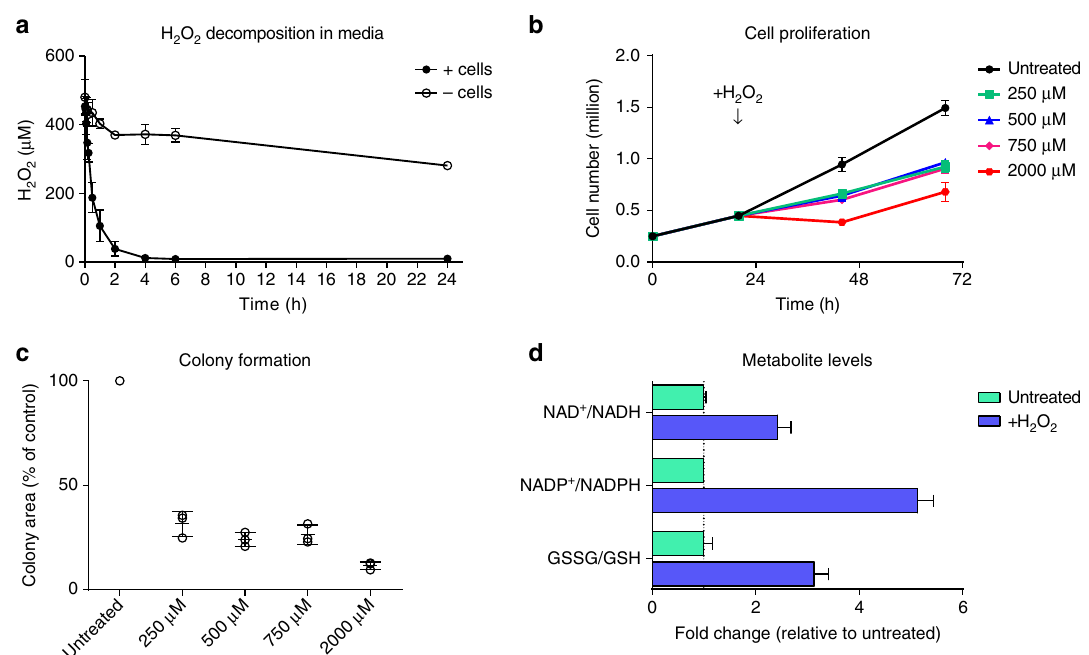
Fig. 3 Treatment with hydrogen peroxide causes recoverable oxidative stress in Fh1 fl / fl cells. a Stability of hydrogen peroxide in culture media with or without cells after treatment with 500 µ M hydrogen peroxide. b Cell proliferation after hydrogen peroxide treatment. Media was replaced after 15 min of treatment. c Colony formation capacity after hydrogen peroxide treatment. Assays were started after 15 min of treatment. d Relative ratios of intracellular NAD + /NADH, NADP + /NADPH and GSSG/GSH after treatment with 500 µ M hydrogen peroxide for 15 min. a – d All graphs show mean (S.D.) of